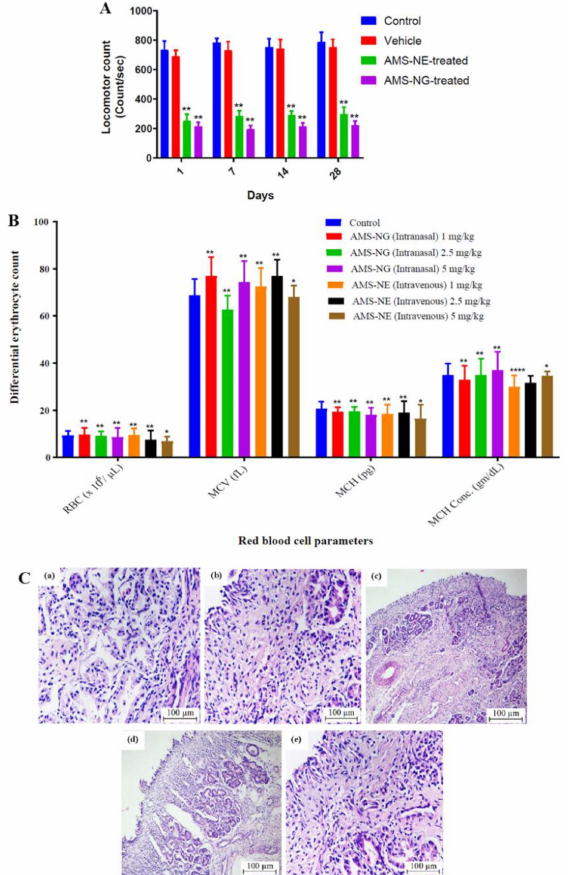
Figure 5. ( A ) locomotor activity after chronic intranasal administration of amisulpride nanoemul- gel (AMS-NG-treated) or nanoemulsion (AMS-NE-treated) (compared to control and vehicle); ( B ) hematological toxicity (differential erythrocytes parameter counts) after intranasal administra- tion of the amisulpride nanoemulgel (AMS-NG (Intranasal)) and intravenous administration of the nanoemulsion (AMS-NE (Intravenous)), at several doses; ( C ) histopathological examination of a rat nasal mucosal section after chronic exposure to several doses of the amisulpride nanoemulgel ( b – d ) (compared to control ( a ), and vehicle ( e )); adapted from Gadhave et al. [33], reproduced with permission from Elsevier [License Number 5393040123016]. * p < 0.05, ** p < 0.01, **** p < 0.0001 vs. control